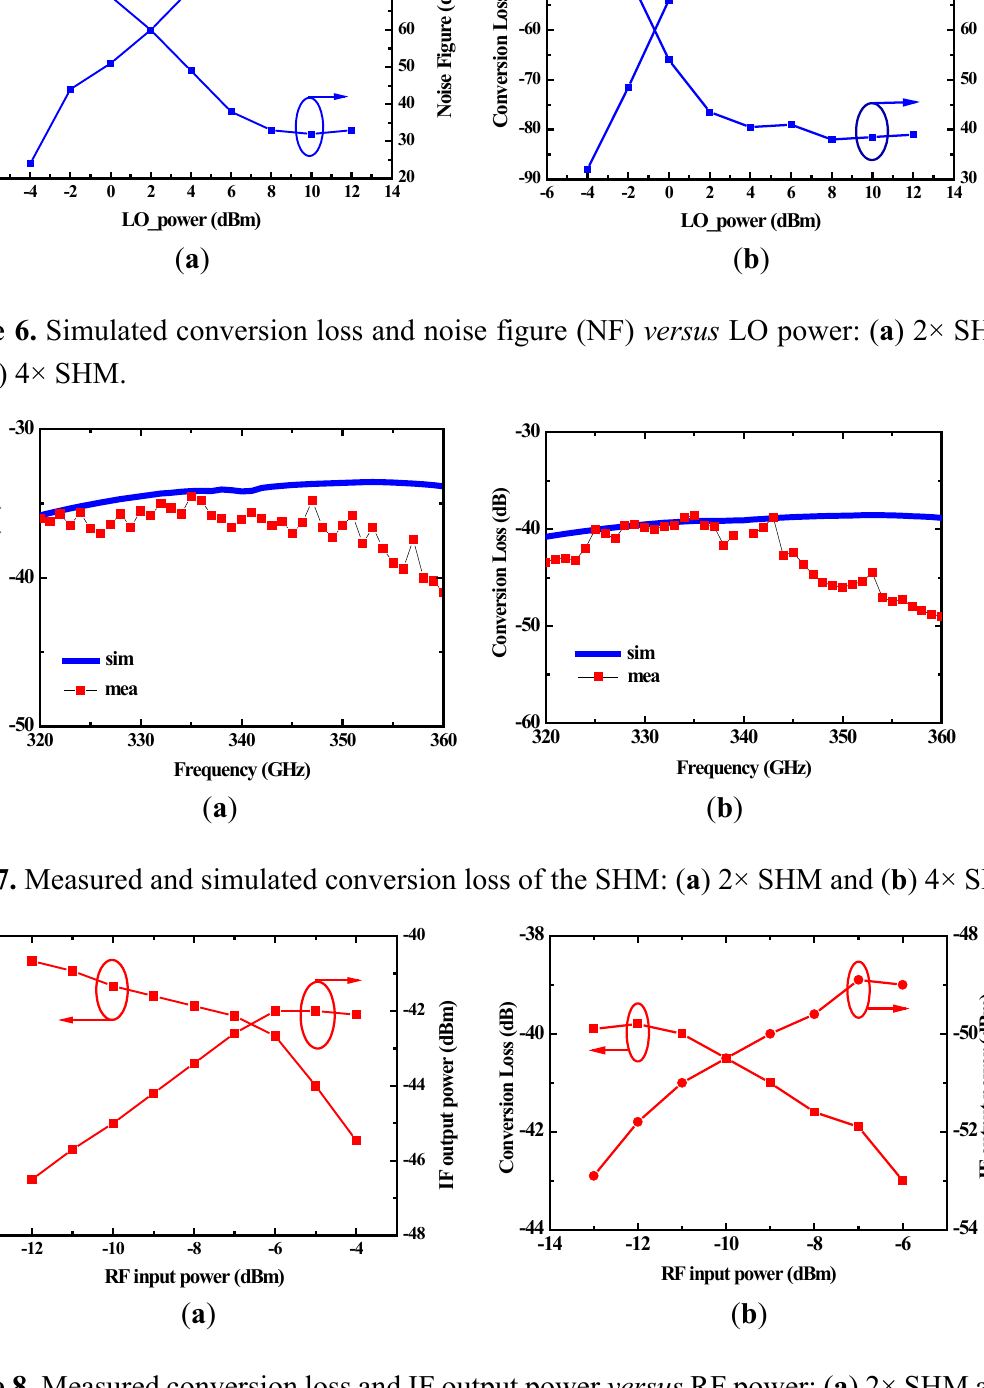
Figure 8. Measured conversion loss and IF output power versus RF power: ( a ) 2× SHM and ( b ) 4×